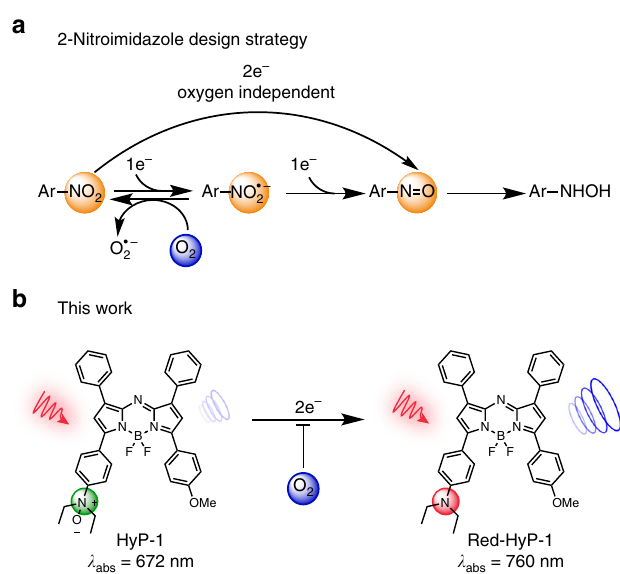
Fig. 1 Design strategies used for hypoxia-responsive probe development. a Enzymatic reduction of 2-nitroimadazoles. One-electron reductases reduce the nitro to the corresponding nitro radical anion, which can be rapidly reversed by oxygen. In the absence of oxygen, a subsequent reduction affords the nitroso, which can then undergo further reduction and irreversible crosslinking with intracellular nucleophiles. b Chemical structure of HyP-1 and red-HyP-1. HyP-1 undergoes irreversible two- electron reduction by heme proteins such as CYP450 enzymes in the absence of oxygen, which binds competitively to the heme iron. Red-HyP-1 produces an enhanced PA signal (blue circles) upon irradiation at 770